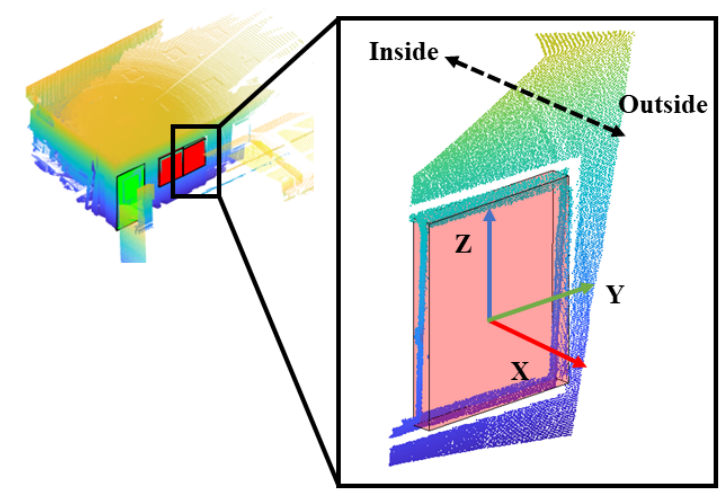
Figure 3. The principle of generating local coordinates on the bounding